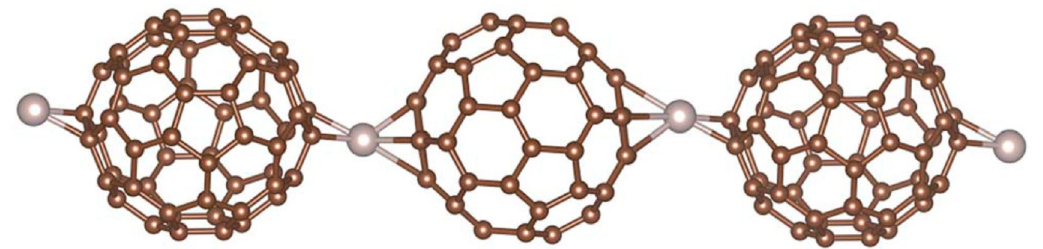
Figure 4. One-dimensional Ru–C 60 polymer. Ru atoms are in grey [36].